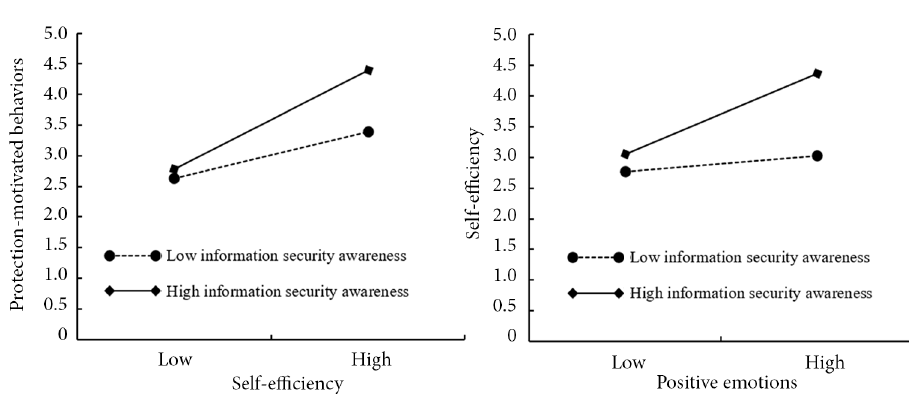
Figure 2. Analysis of moderated mediating